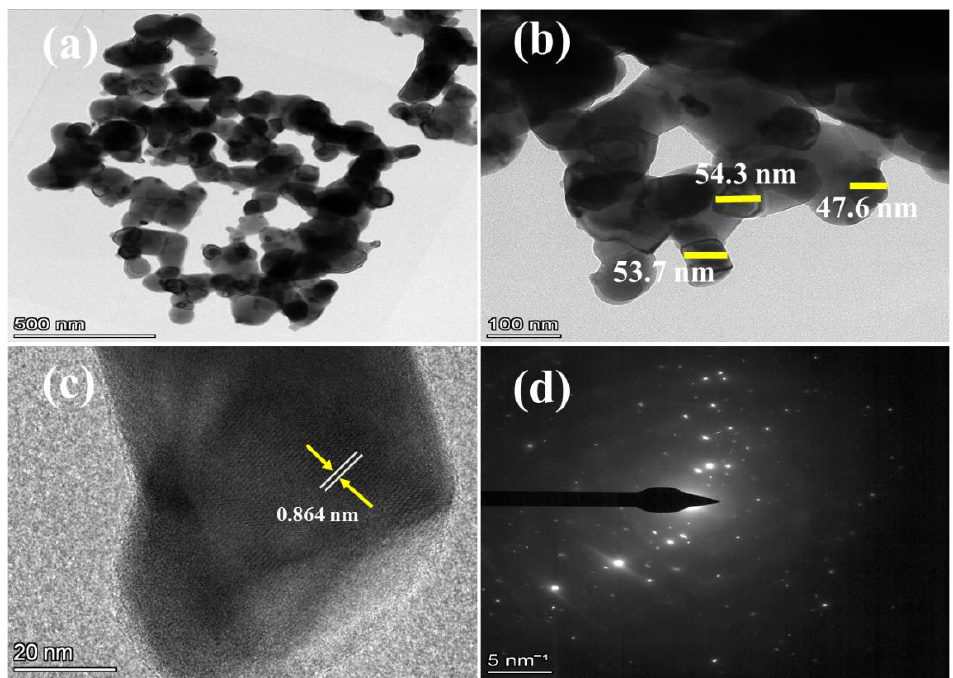
Figure 5. ( a – c ) HR-TEM micrographs and ( d ) SAED assessment of as-prepared Ce 0.1 La 0.9 MnO 3 (CLMO)